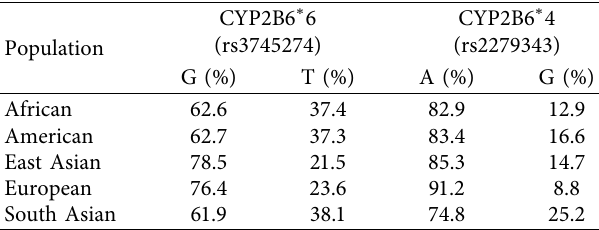
Table 5: CYP2B6 ∗ 6 and ∗ 4 allele frequencies as reported in various superpopulations in the 1000 Genome